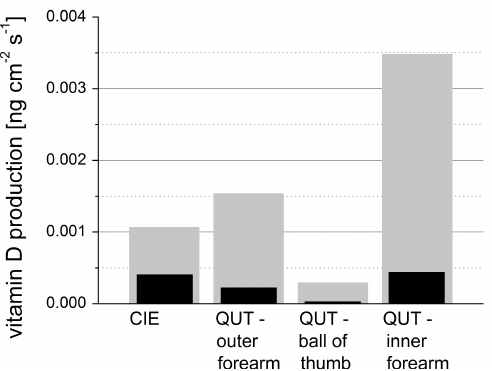
Figure 28. Total previtamin D production from solar (black) vs. artificial (gray) irradiation as predicted by our model (QUT) for different skin sites and assuming a step function ( left panel) or a smooth ( right panel) provitamin D concentration profile in the skin. Results from the CIE standard spectrum where skin properties are implicit are given for comparison (reproduced with permission from